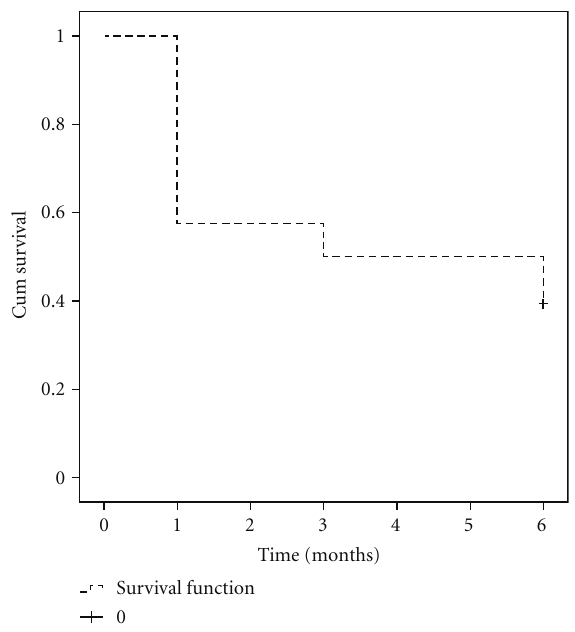
Figure 2: Kaplan-Meier survival curves for eyes with POAG (Curve 1) versus eyes with PXFG (Curve 2) with the success criteria defined as an IOP reduction ≥ 20% from baseline without changing the antiglaucoma medication with no need for further laser trabeculoplasty or glaucoma surgery; P = 0 . 025 log rank test.